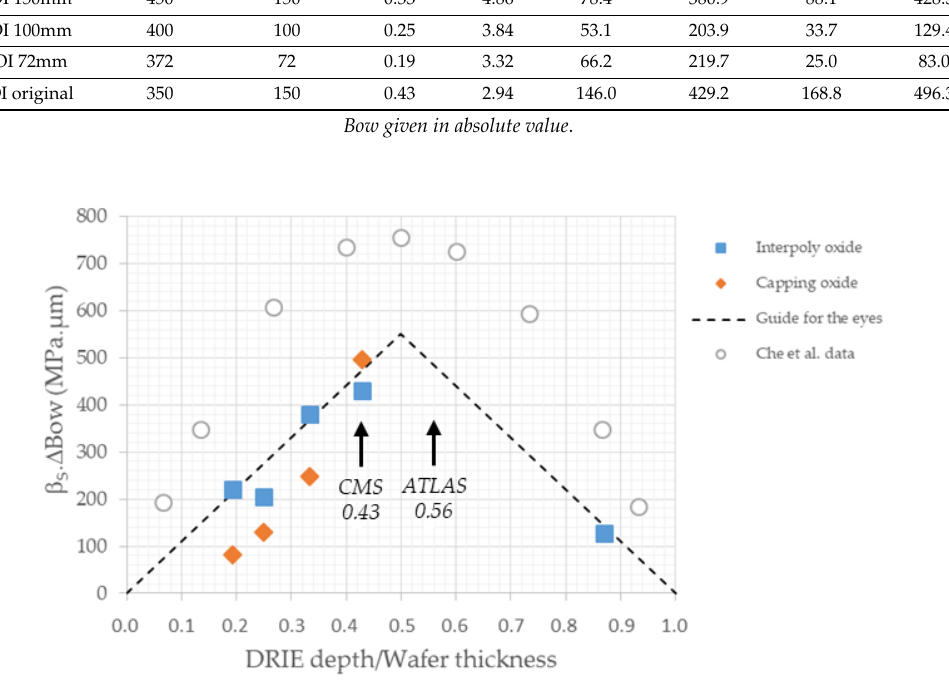
Figure 19. Parametrized bow versus DRIE depth to wafer thickness ratio of critical steps in 3D detector technology. Dotted lines are guide for the eyes. Data from [47] are reproduced for comparison. Values of DRIE depth to wafer thickness ratio for ATLAS and CMS HL-LHC production are also indicated.